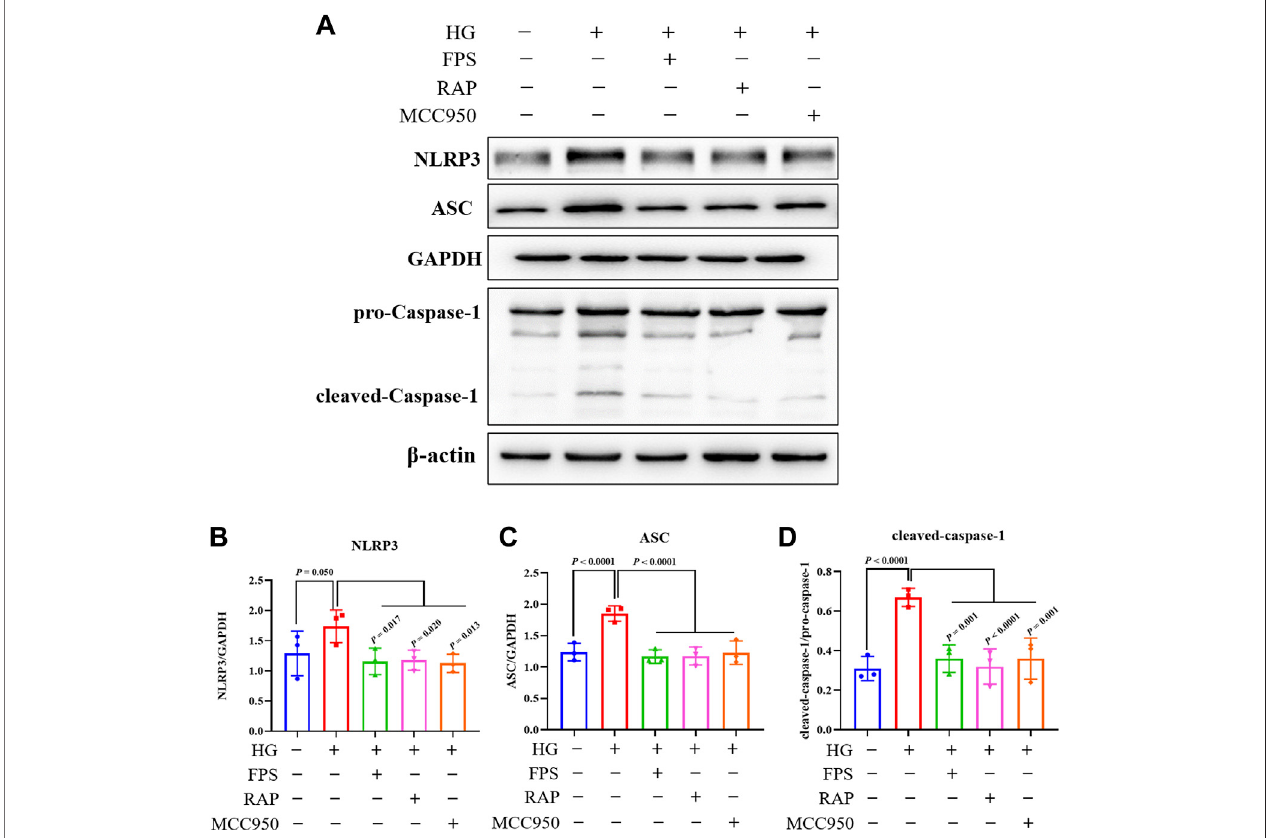
FIGURE 11 | Effects of FPS and RAP on the activation of NLRP3 in fl ammasome in vitro . (A) The WB analysis of NLRP3, ASC, pro-Caspase-1, and cleaved- Caspase-1 in MPC-5 cells exposed to HG with or without FPS or RAP or MCC950 for 24 h. (B – D) The rate of NLRP3, ASC, and cleaved Caspase-1 to GAPDH or pro- Caspase-1, respectively. The data are expressed as the mean ±